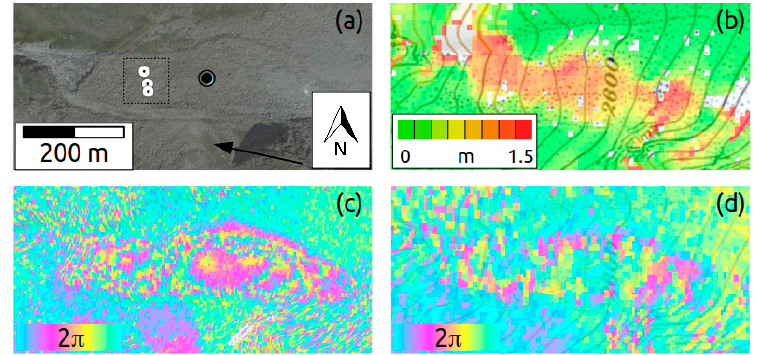
Figure 4. ( a ) Tsarmine rock glacier (Val d’Arolla, Switzerland) with positions of the GNSS stations used for offset tracking validation (white dots), of the Cosmo-SkyMed offset tracking time series of Figure 5a (dotted square) and of the Sentinel-1 InSAR time series of Figure 5b (black dot), image data are from Google, DigitalGlobe; ( b ) Displacement along the terrain surface from Cosmo-SkyMed offset tracking from 27.08.2010 to 14.08.2011; ( c ) Cosmo-SkyMed interferogram from 15.09.2017 to 24.09.2017, 2 π ⇔ 1.6 cm; ( d ) Sentinel-1 interferogram from 24.09.2017 to 30.09.2017, 2 π ⇔ 2.8 cm. The black arrow indicates the satellite line-of-sight.